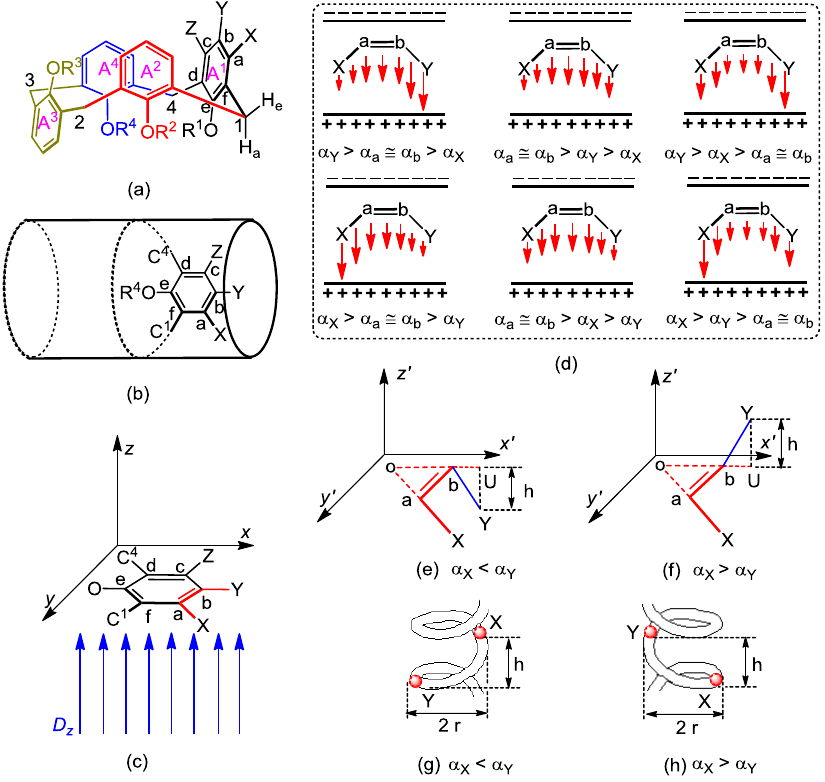
Figure 2. Helical character analysis of microhelix X–a–b–Y in inherently chiral calix[4]arene. inherently chiral calix[4]arene model ( a ); complex planar chiral model of aromatic ring A 1 ( b ); helical character analysis of aromatic ring A 1 ( c ); different electron movement of bond Xa , ab and bY ( d ); electron movement of bond bY relative to xy plane when α < α ( e ); electron movement of bond bY relative to xy plane when α > α ( f ); X Y X Y right-handed cylindrical microhelix model when α < α ( g ) and left-handed cylindrical X Y > α ( h microhelix model when α Y X